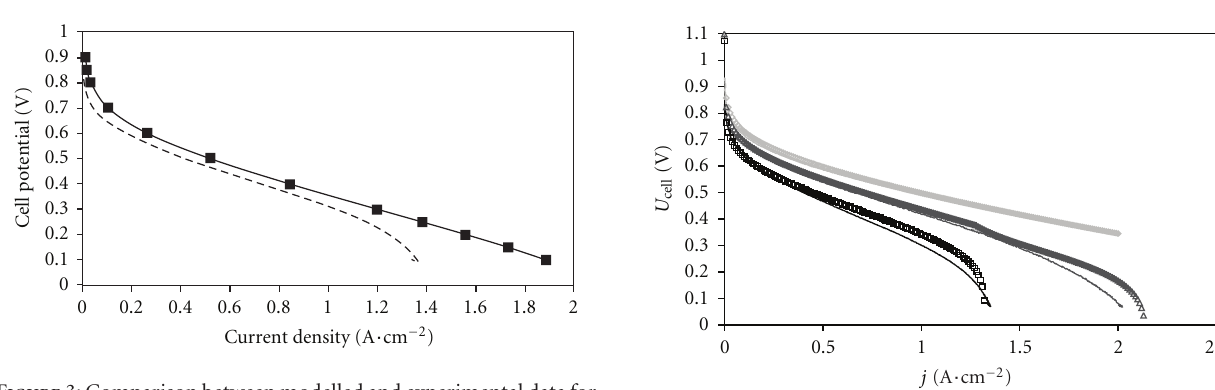
Figure 3: Comparison between modelled and experimental data for a PEM fuel cell utilising 50% Pt/C at the cathode and 20% Pt/C at the anode at 150 ◦ C. Air was used at the cathode and hydrogen at the anode at atmospheric pressure. (a) (cid:2) model; (b) – – experimental.